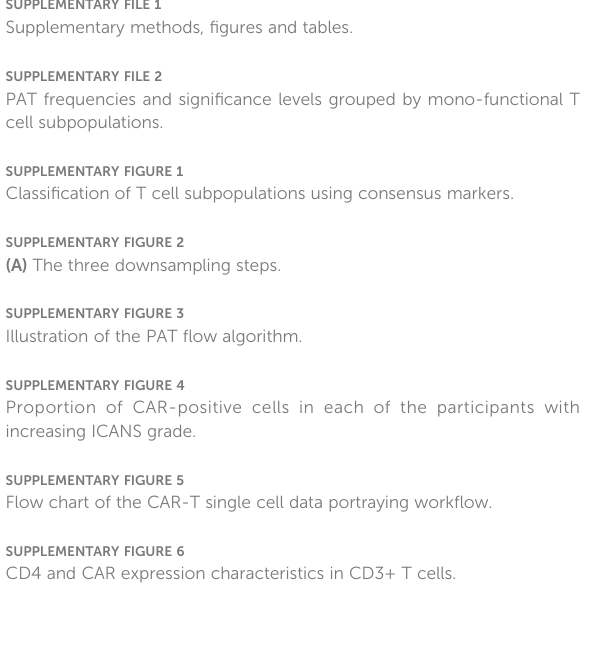
SUPPLEMENTARY FIGURE 9 Expression of module B in single cells.